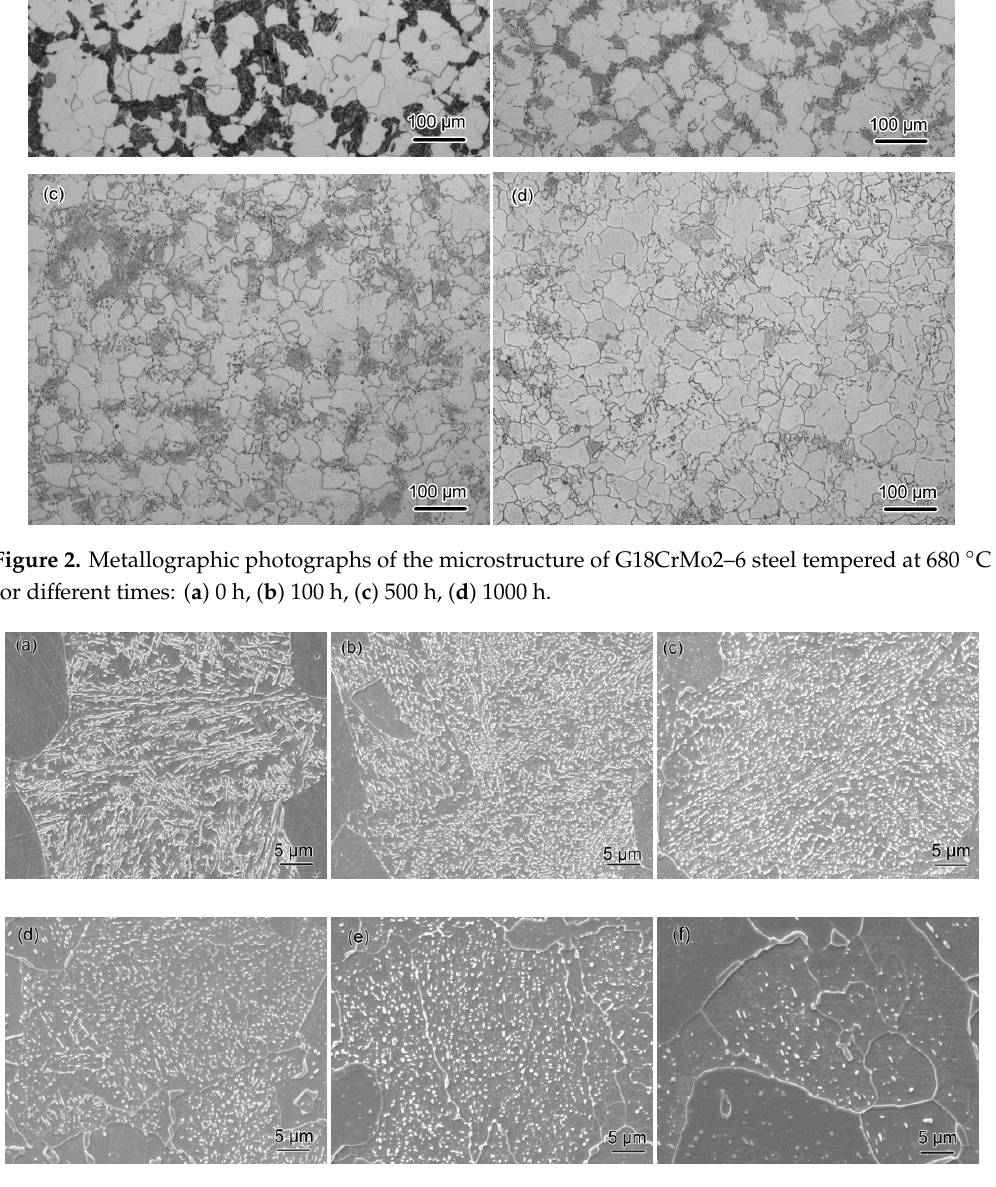
Figure 2. Metallographic photographs of the microstructure of G18CrMo2–6 steel tempered at 680 °C for different times: ( a ) 0 h, ( b ) 100 h, ( c ) 500 h, ( d ) 1000 h.